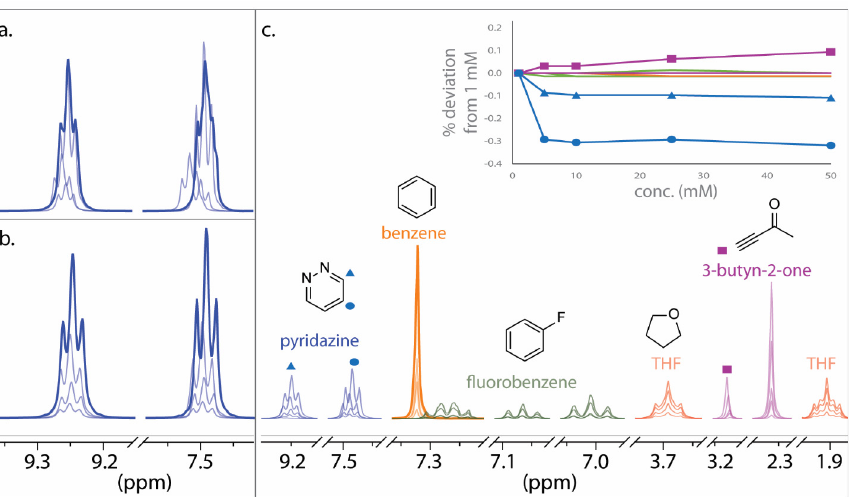
Figure 3. Proton chemical shift dependence as a function of concentration in CDCl 3 . ( a ) Pyridazine without K 2 CO 3 . ( b ) Pyridazine with K 2 CO 3 to neutralize residual DCl. ( c ) 600 MHz NMR spectral overlays for individual compounds. Concentrations were varied from 1 to 50 mM. The largest chemical shift deviations with respect to concentration are highlighted for pyridazine (blue triangles and circles) and the alkyne proton of 3-butyn-2-one (pink